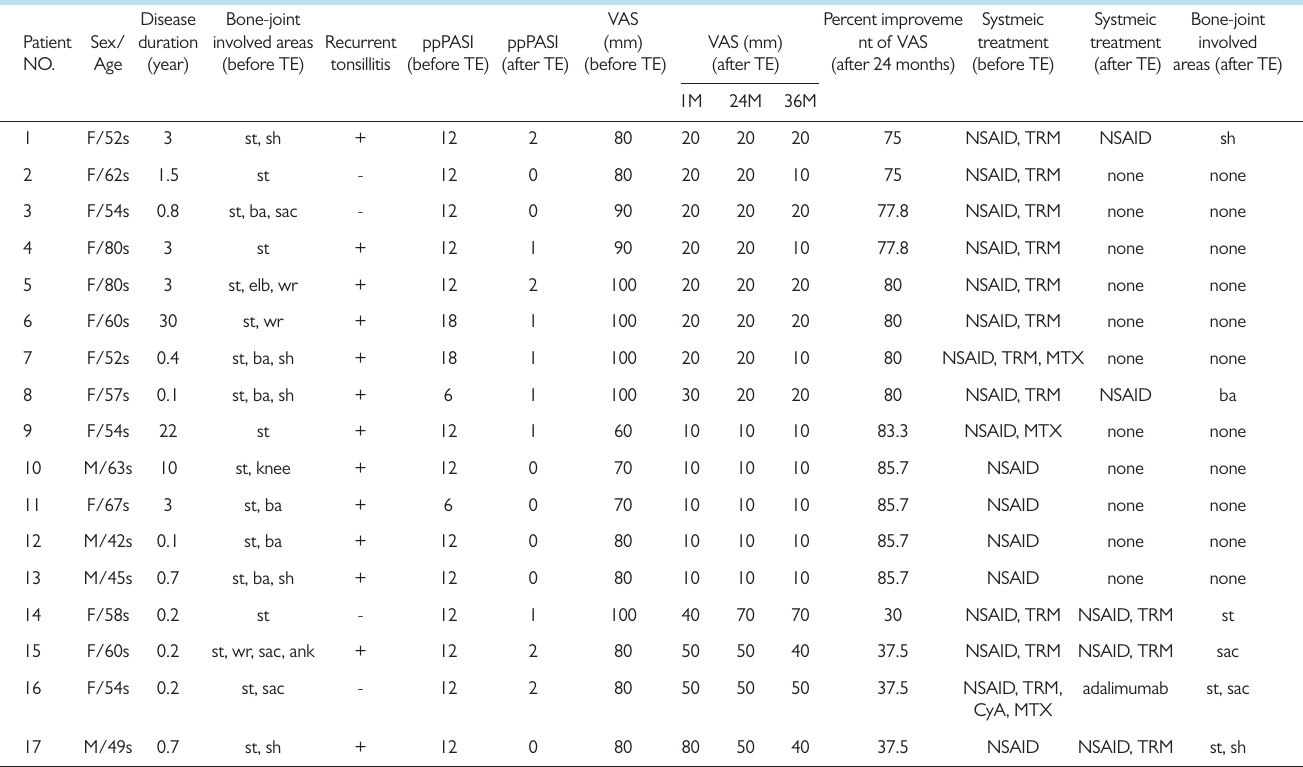
Table 1. Summary of the 17 patients with PAO. The 17 patients’ ppPASI value and VAS score before and after tonsillectomy